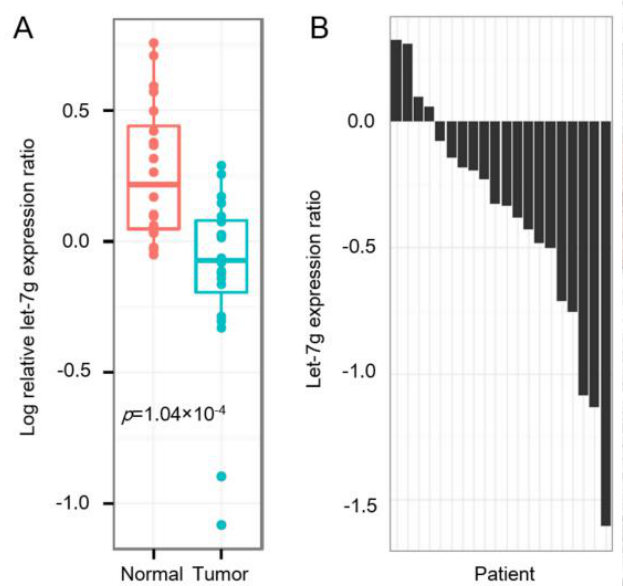
Figure 2. Expression of let-7g in a cohort of colorectal cancer (CRC) patients. ( A ) Whisker boxplot shows let-7g mRNA values of tumor tissues and paired adjacent normal tissues in 20 CRC samples. ( B ) Bar plot shows the relative expression ratio between let-7g from tumor versus paired normal tissues around the cancer tissue of each CRC